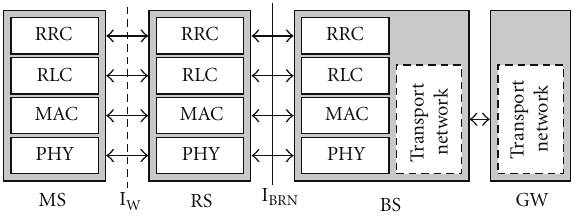
Figure 1: RSs within the cellular network, the control plane.